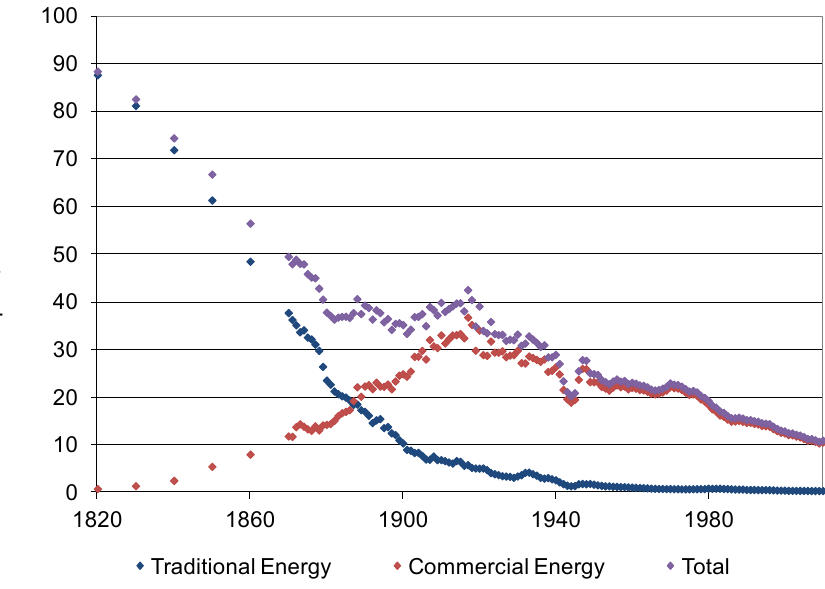
Figure 17. U.S. energy intensity 1820–2010. Sources: various; see individual energy series in Section 2.